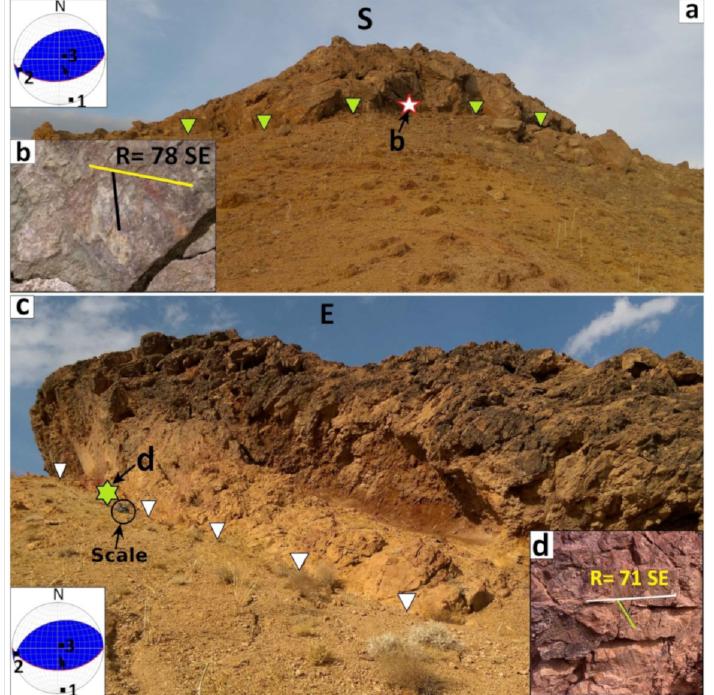
Figure 5. ( a ) Field photo of F23 fault trace that is reverse with dextral strike-slip mechanism. ( b ) Slickenline on the minor fault in part. ( c ) Trace of F22 fault which is reverse with a dextral component. ( d ) Slickenline on the minor fault in part. Numbers 1, 2, and 3 in the stereonet represent the direction of the main stress axes, while the arrow represents the trend of movement of the hanging